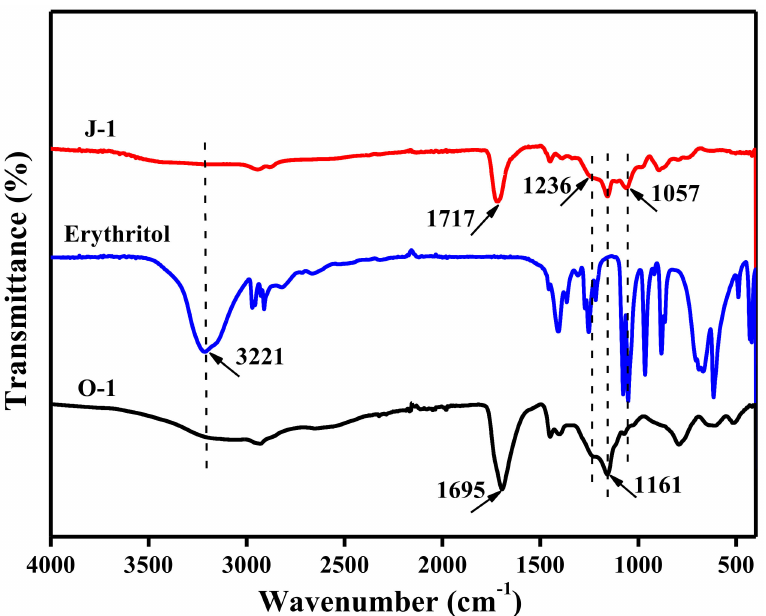
Figure 1. FTIR spectra of the prepared fibers O-1 and J-1; fiber O-1 is defined in Section 2.3, and fiber J-1 is described in Section 2.4.